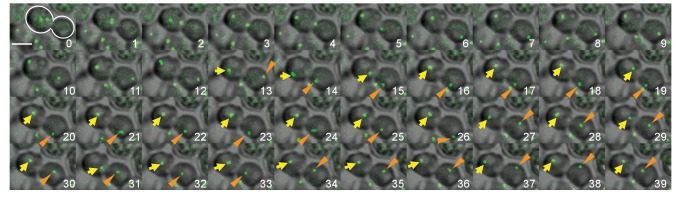
Behaviour of SPB during spindle alignment and mitosis.Another example of time lapse microscopy shown in Figure 1E. MPS3-GFP cells (HPH1681) were grown in SD complete medium at 30°C. Consecutive sections were taken every 60 s. Yellow arrows and orange arrowheads point SPB. Shown are deconvolved and projected GFP images merged with bright field image. Scale bar, 2 µm.